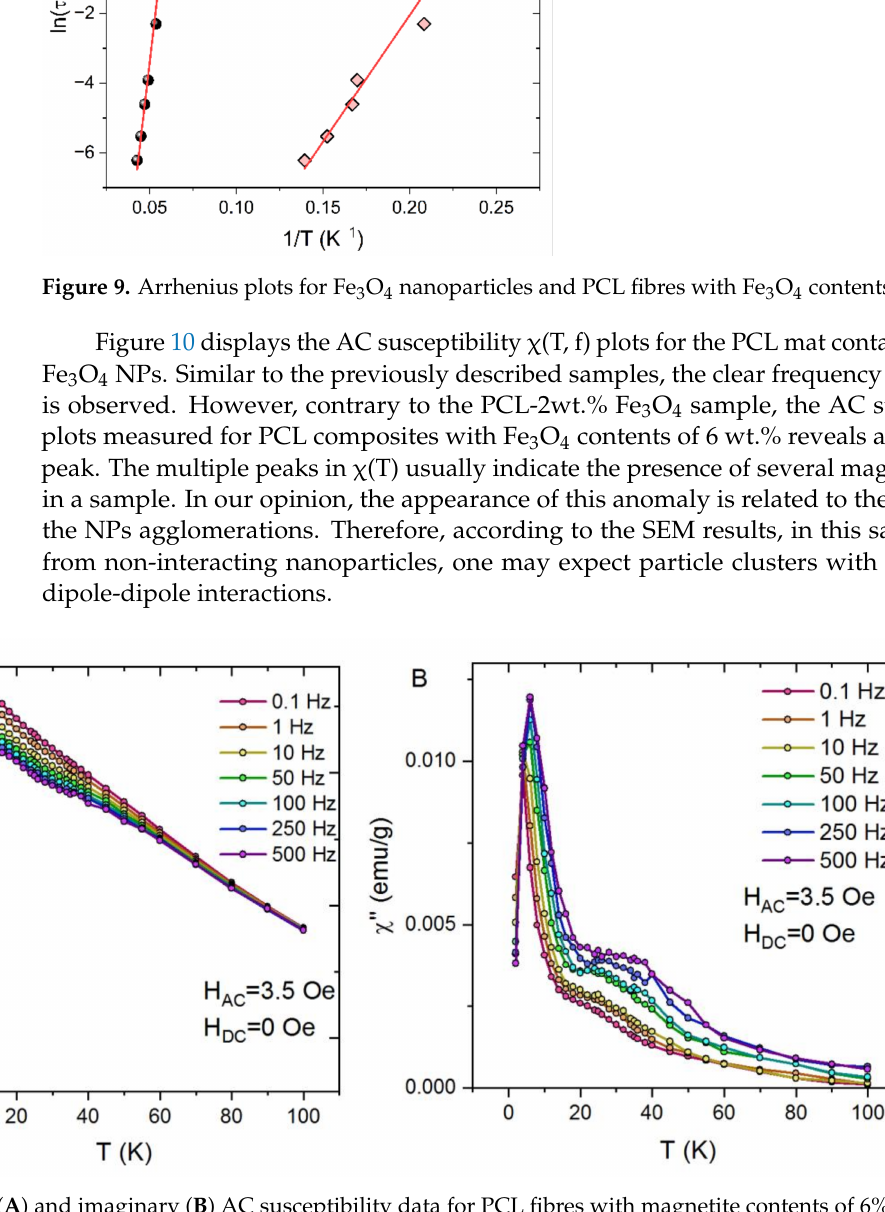
Figure 10. Real ( A ) and imaginary ( B ) AC susceptibility data for PCL fibres with magnetite contents of